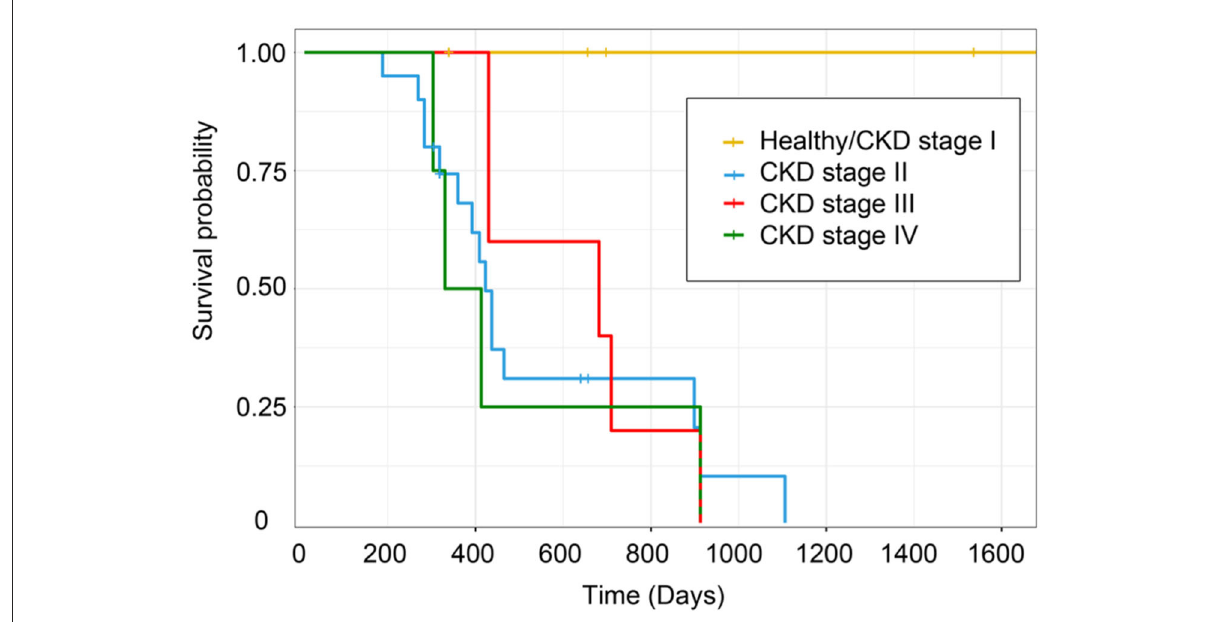
FIGURE13 Kaplan–Meier survival estimates by CKD stage. The survival curve of each CKD stage shows the survival time based on the staging of